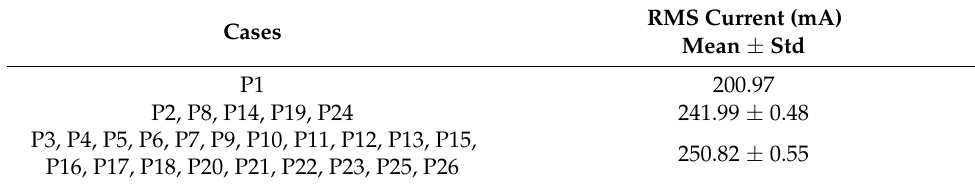
Table 3. WSS current consumption depending on the defined measurement